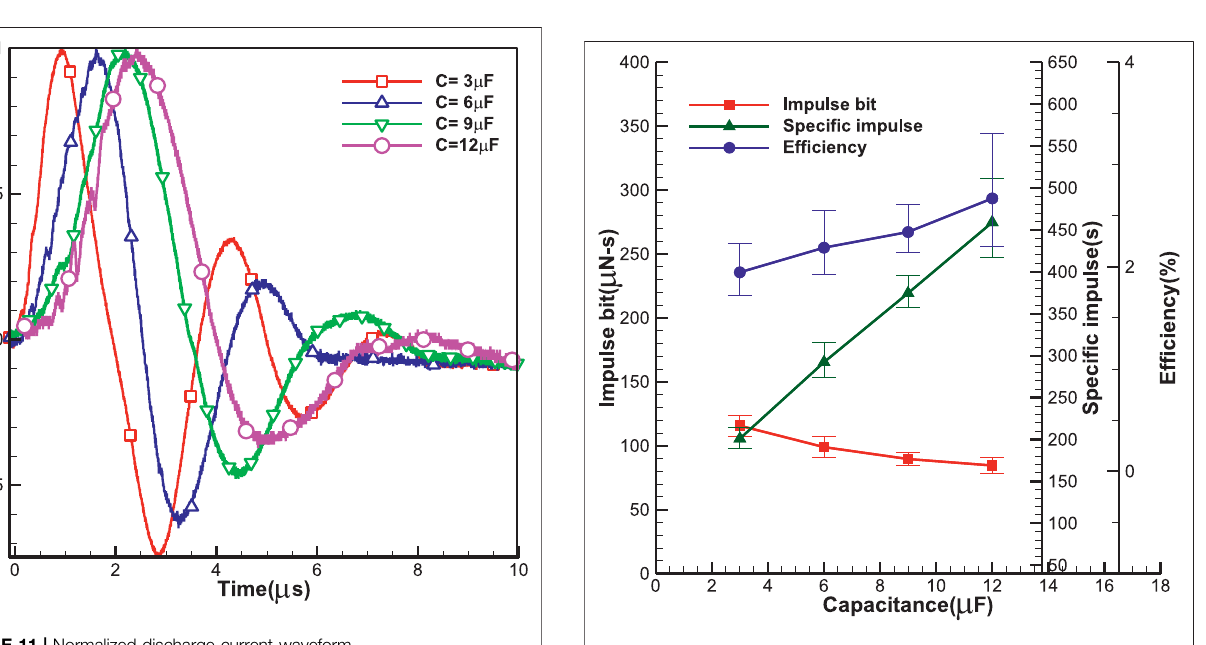
FIGURE 12 | APPT thruster performances under different capacitance and voltage con fi